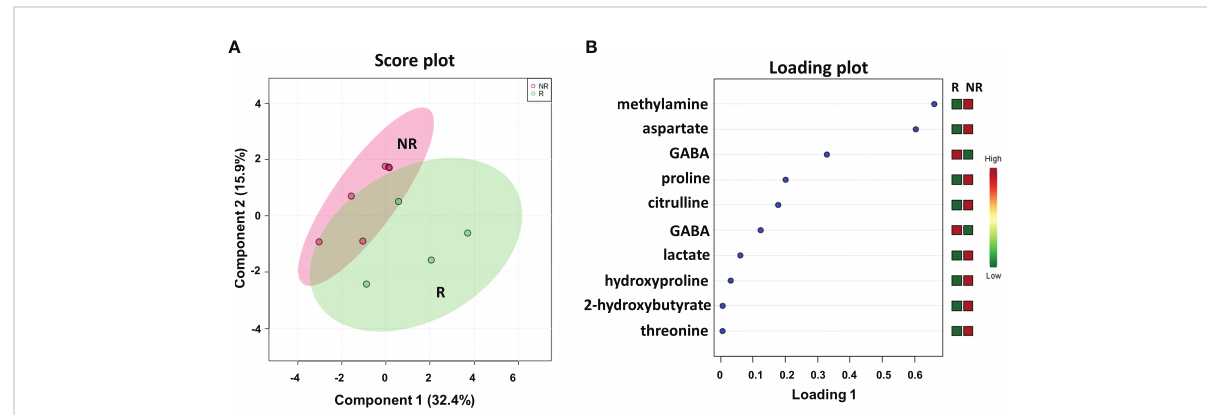
FIGURE 5 Score plot (A) and loading plot (B) related to metabolomic pro fi ling, on resected liver metastases tissues 4 R and 6 NR mCRC subdivided accordingly to DFS in good (R; DFS ≥ 1 year) and bad (NR; DFS < 1 year)